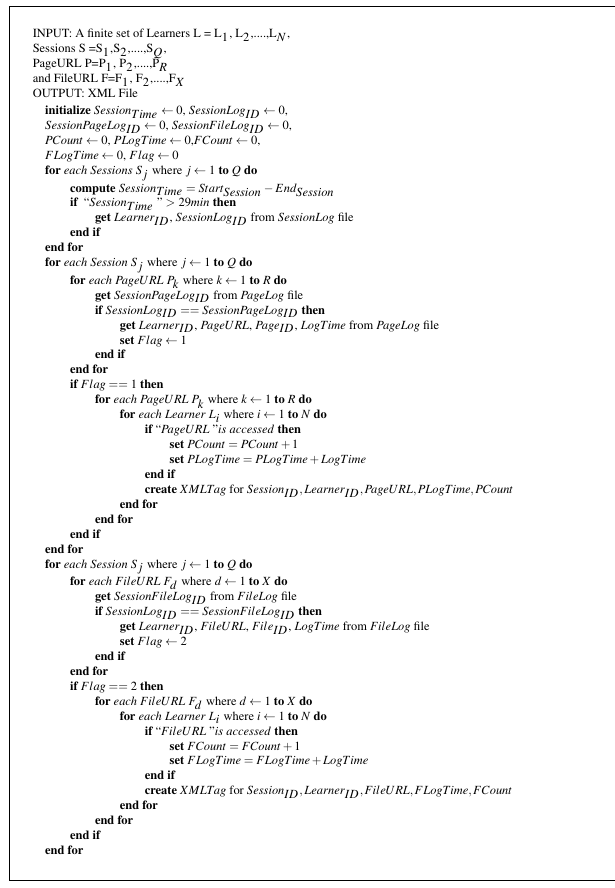
Algorithm 1: XML File1 Generation